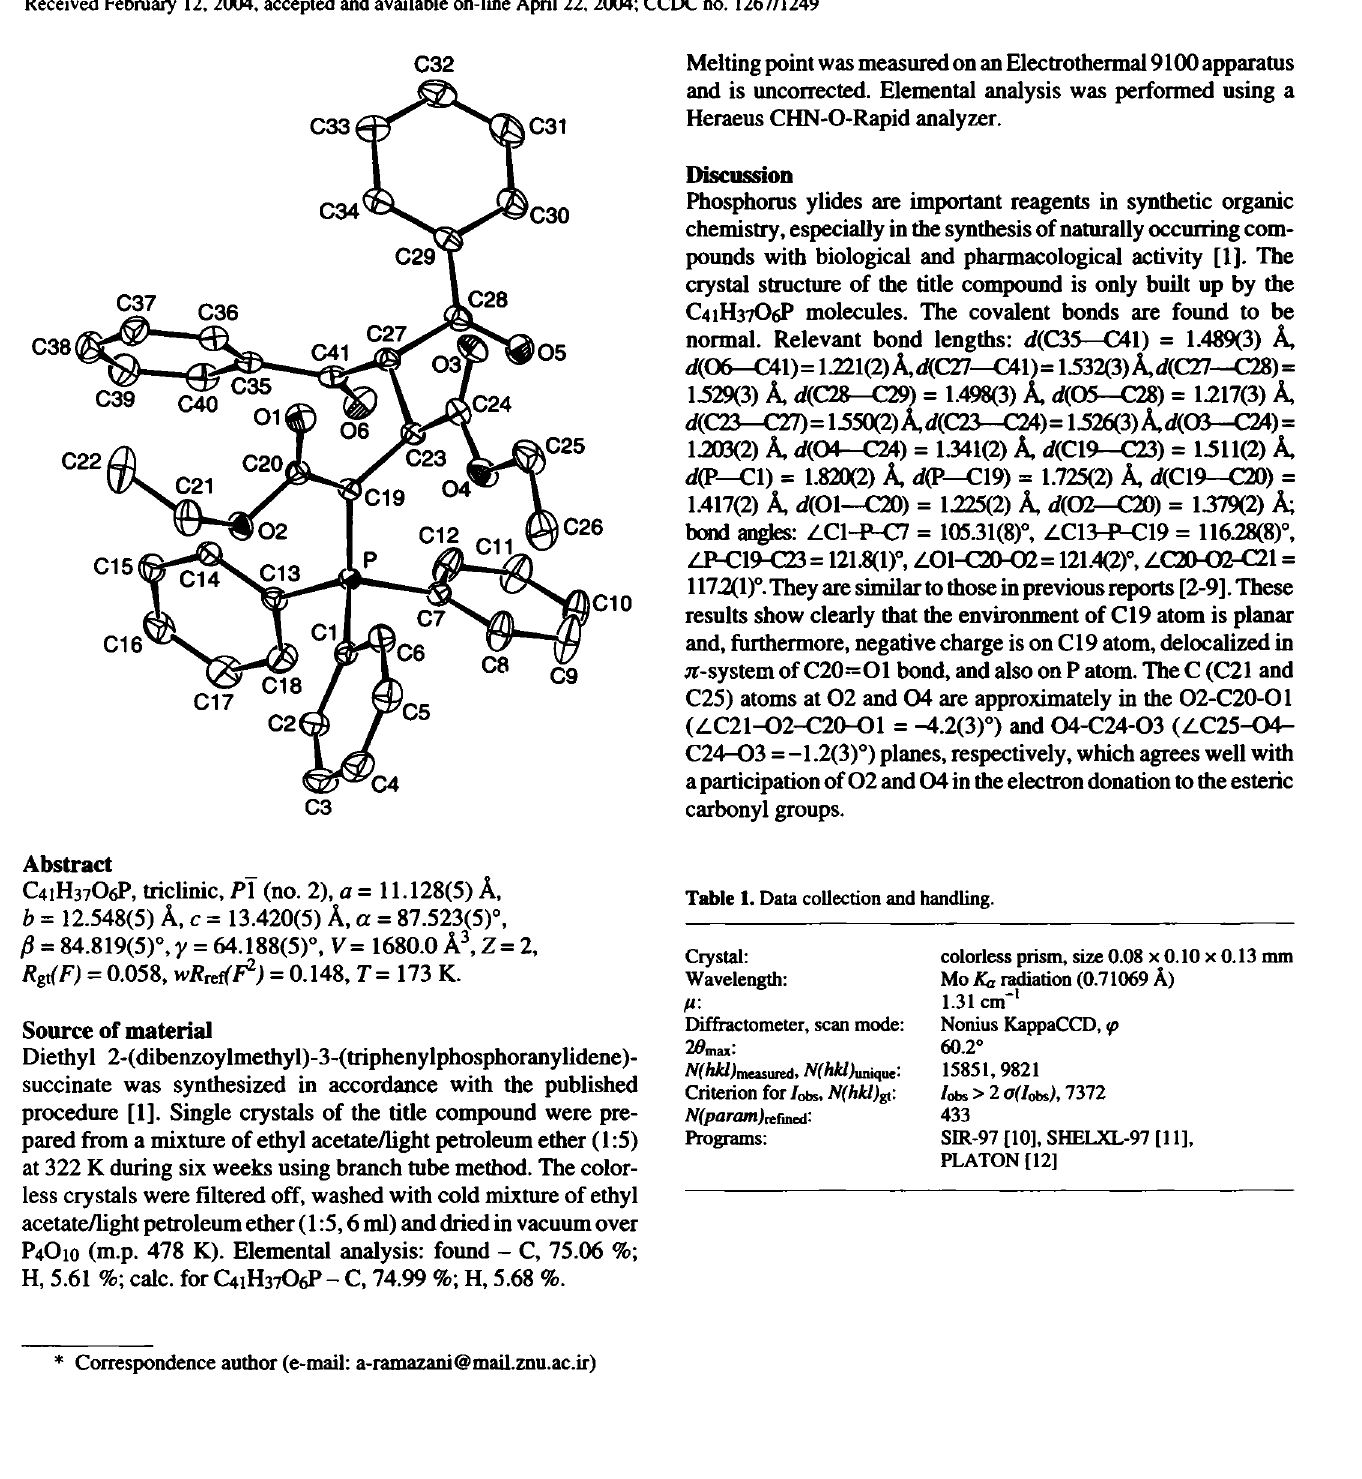
Table 1. Data collection and